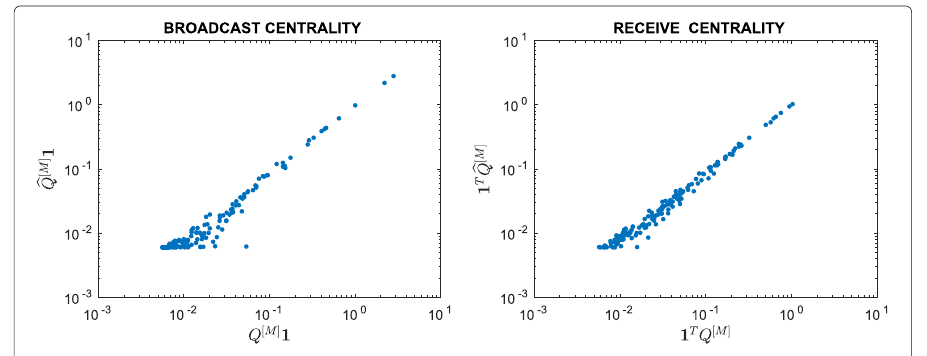
Fig. 3 Scatter plot. Enron: approximation using (4) with α = 0.01